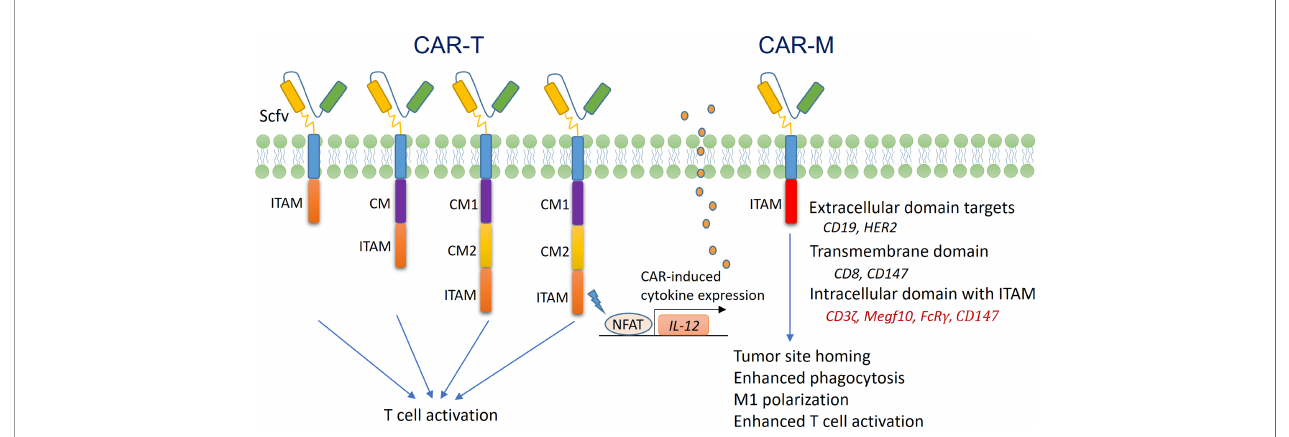
FIGURE 4 | Structure and function of CAR-T cells and CAR-Ms. (Left) The structure of fi rst-generation T cell CARs mainly includes an ScFV extracellular domain that recognizes tumor antigens, a TM domain, and an intracellular domain that contains ITAM and is responsible for signal transduction (usually derived from the intracellular domain of CD3 z ). The structure of second-generation T cell CARs includes an additional intracellular signal transduction domain from costimulatory molecules (CMs), such as CD28 and 4-1BB. The structure of third-generation T cell CARs includes two or more CM domains, which further enhance T cell activation. The structure of fourth-generation CARs includes a nuclear factor of activated T cells (NFAT)-responsive gene expression cassette, which drives the expression of an immunoregulatory gene, such as IL-12. Once CAR-T cells are activated, NFAT translocates to the nucleus and activates the expression of IL-12, thereby promoting anticancer activity. (Right) Currently, the structure of macrophage CARs is based on that of fi rst-generation T cell CARs. The intracellular domain of CD3 z , FcR g or Megf10 is used for signal transduction. In addition, CAR-Ms are preferentially fi xed at the M1 differentiation status, with enhanced phagocytic and antigen presenting